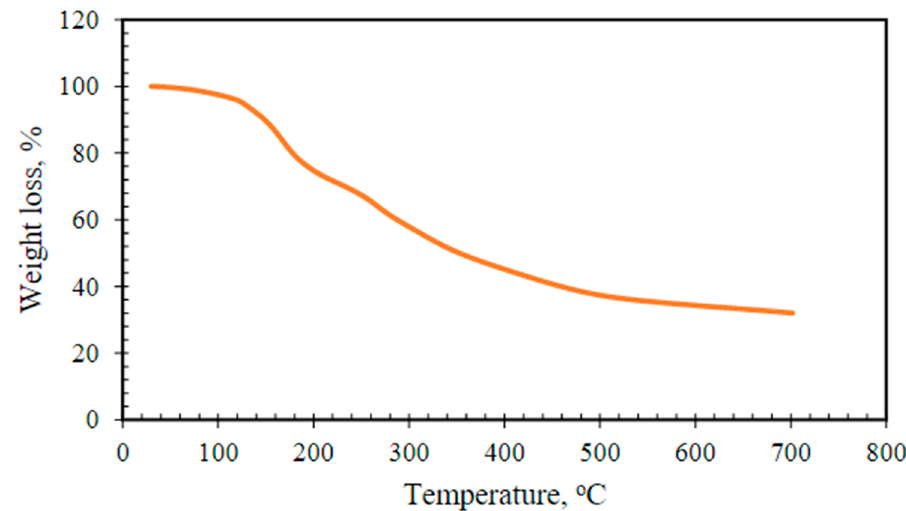
Figure 4. Thermal stability analysis of OM polymer via TGA [30].